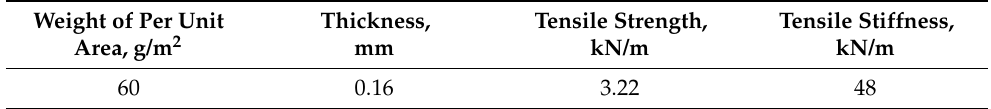
Table 3. Physical and mechanical parameters of the medical gauze.